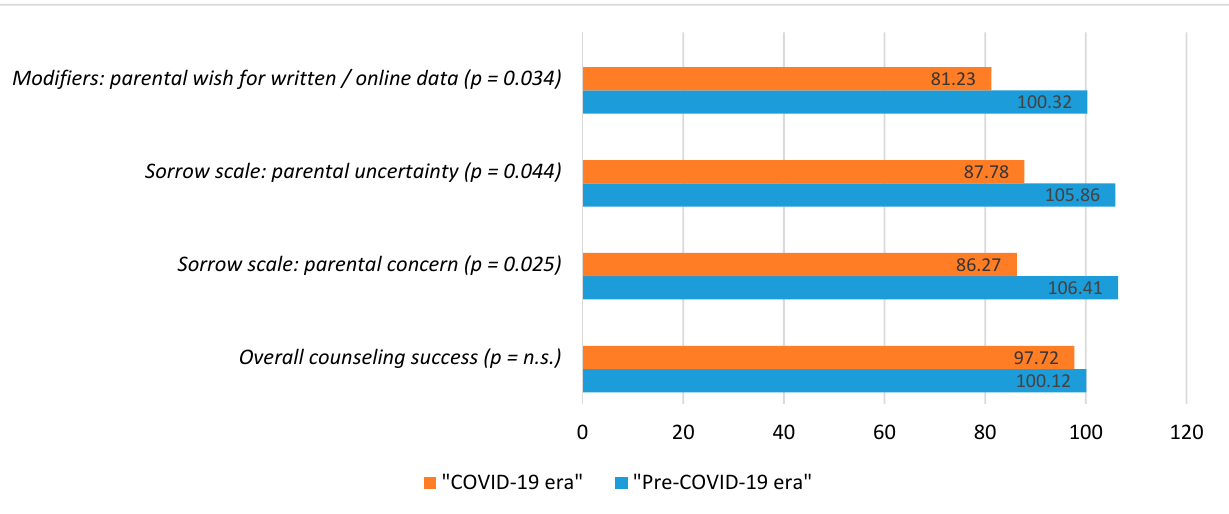
Figure 2. Overview of key results. Mean ranks displayed as column charts incl. p -values (Mann Whitney-U Test) for “Overall Counseling Success“, “Sorrow scales“ and selected modifiers for parental counseling success in the two sub-groups.